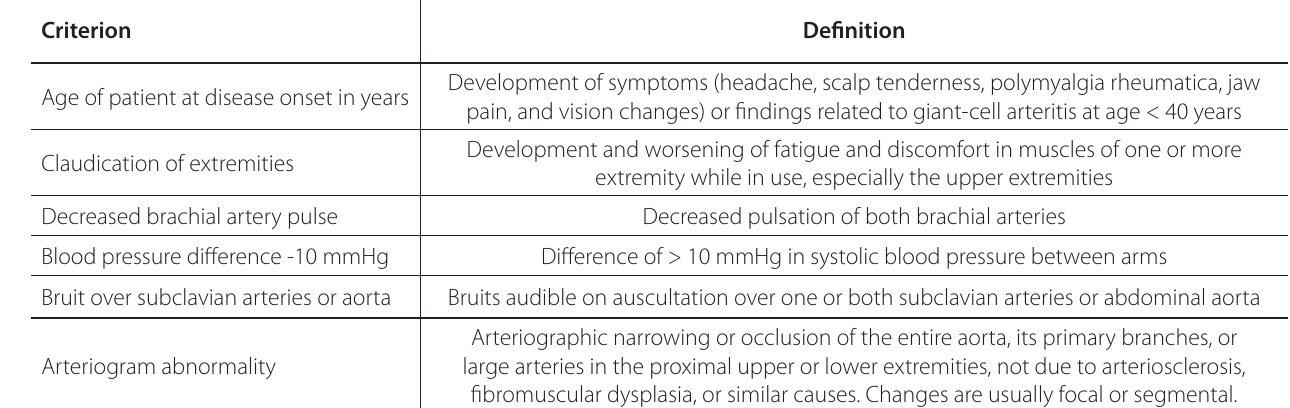
Table 3 . Criteria for diagnosis of giant-cell arteritis.